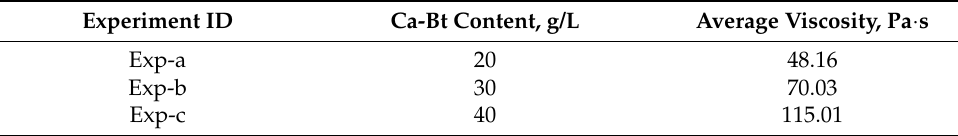
Table 4. Average viscosity values for Exp-a, Exp-b, and Exp-c.